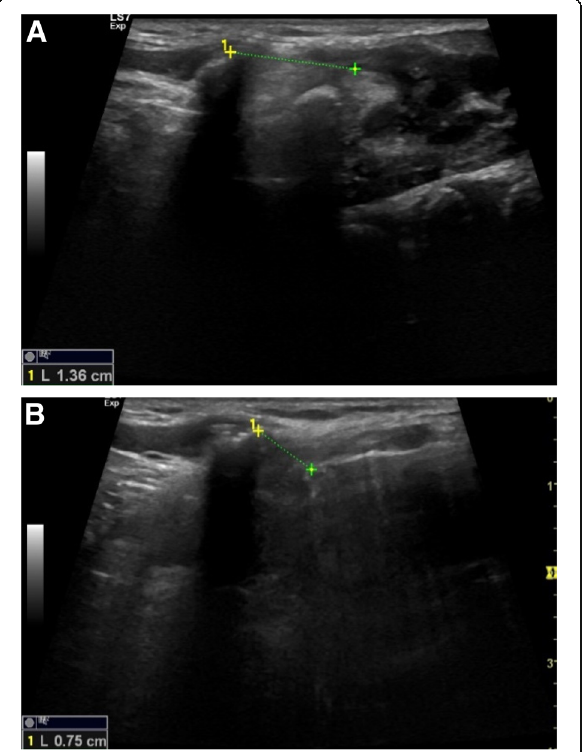
Fig. 2 Measurement of the thyroid cartilage hyoid bone distance. a The hyoid thyroid distance during rest. b The shortest hyoid thyroid distance during